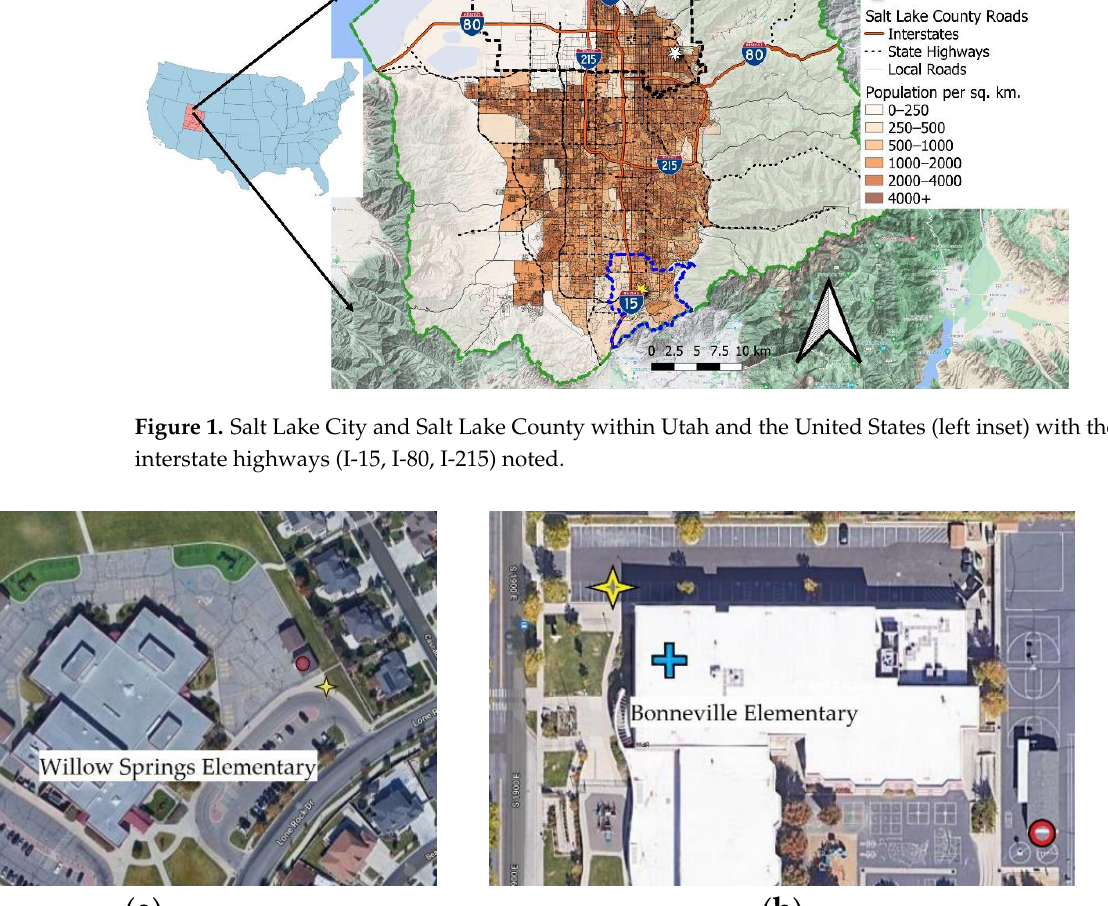
Figure 2. Study area showing the instrument locations at ( a ) Willow Springs Elementary and ( b ) Bonneville Elementary. The parking location of the van is denoted by a yellow star, the playground site is marked by a red circle, and the approximate location of the indoor site is marked by a blue sign. Images courtesy of Google Maps.